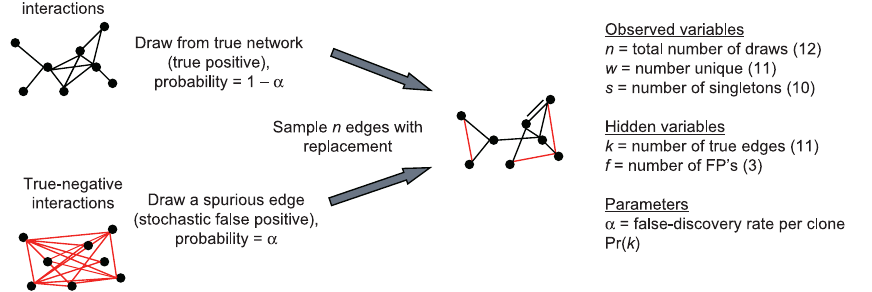
Figure 2. Simplified Schematic Shows the Two-Hybrid Sampling Process In this picture, true-positive interactions (black edges) are sampled uniformly with total probability 1 (cid:2) a , and false-positive interactions (red edges) are sampled stochastically with total probability 1 (cid:2) a . Sampling is with replacement, and multiple edges between a pair of vertices represent multiple observations of the same interaction. The example shows n ¼ 12 edges sampled in the entire network, with w ¼ 11 unique edges and s ¼ 10 edges that are singletons observed once. The total number of true-positive edges, k , and the number of false-positive edges within the sample, f , are hidden. The actual experimental data is more complicated, with individual values reported for n , w , and s for each protein used as a bait. The statistical method presented here provides estimates for k and f together with parameter estimates for a and the distribution Pr( k